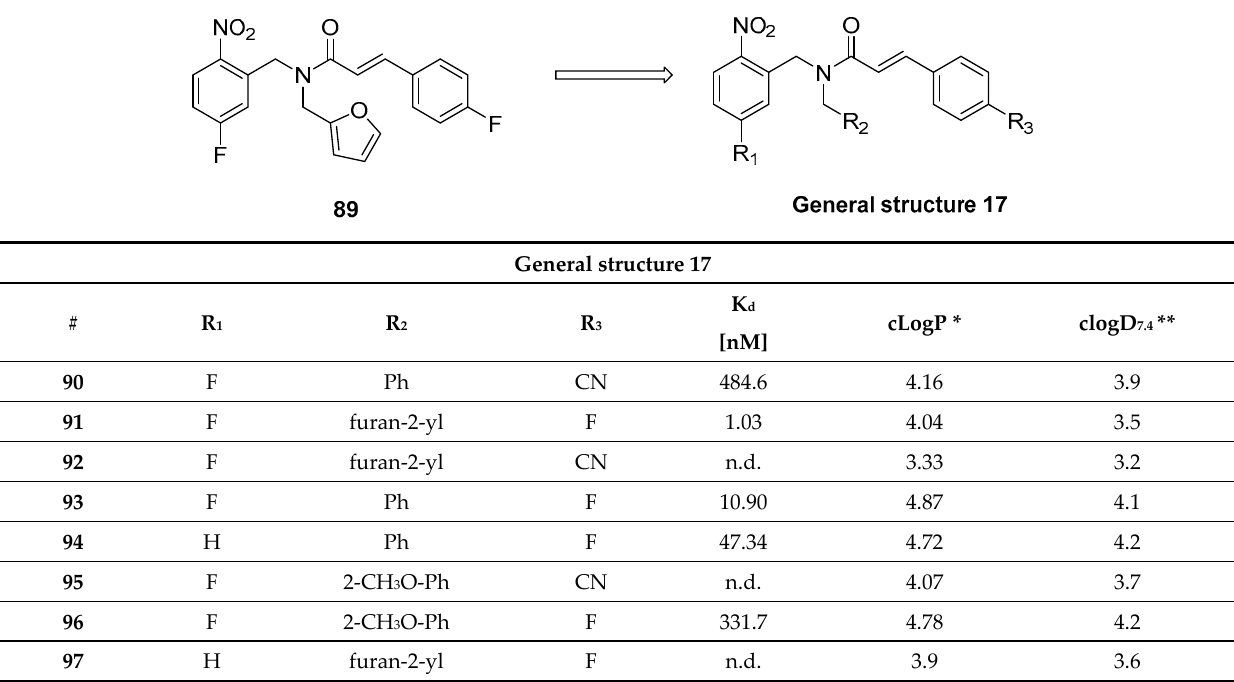
Figure 31. The DBC derivatives tested in SPR assay and structure of DBC compound with binding affinities [148]. * clogP values were calculated by BioByte. ** clogD 7.4 values calculated by ACD/Percepta.